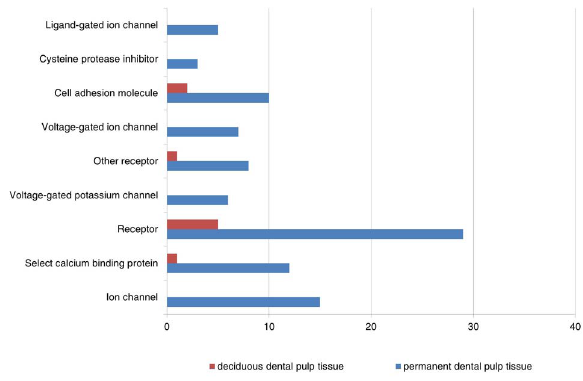
Figure 3. Main categories of genes expressed specifically in deciduous and permanent dental pulp tissues on the basis of their molecular functions ( F -statistic p , 0.05).